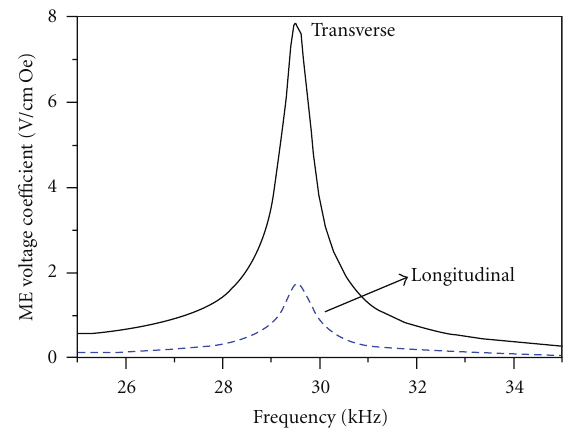
Figure 13: Frequency dependence of longitudinal and transverse ME voltage coe ffi cients for a bilayer of permendur and PZT showing the resonance enhancement of ME interactions at the bending mode frequency. The bilayer is free to bend at both ends . The sample dimensions are L = 9.2 mm and total thickness t = 0.7 mm and the PZT volume fraction v = 0 . 6.